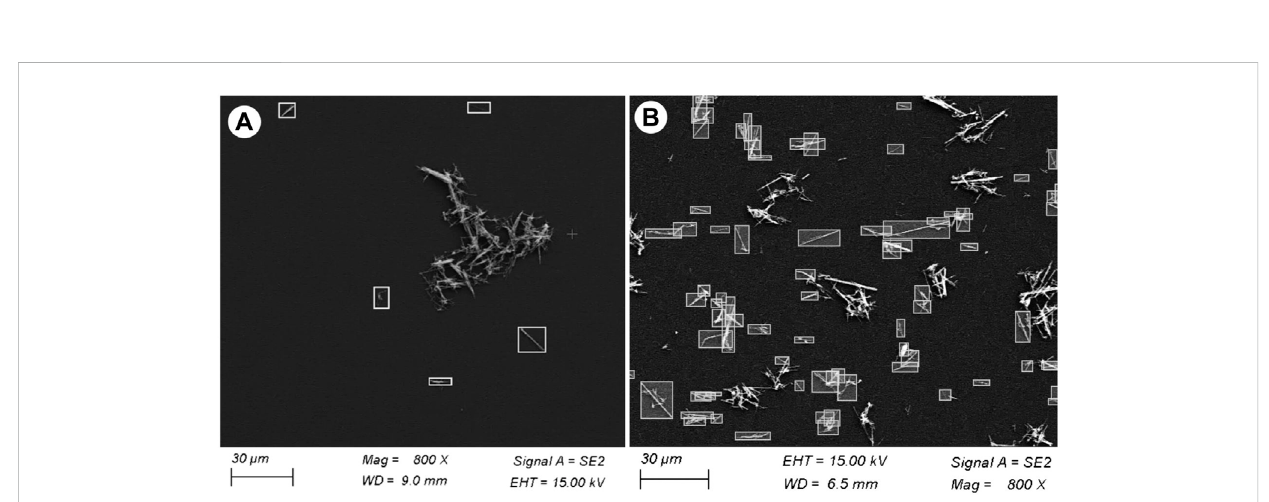
FIGURE 9 SelectedSEMimagesshowingasbestiform fi bresmanuallyannotatedasboundingboxesforcounting.Thechoiceofthe fi brestoannotatehasbeen based on NIOSH (Ashley and O ’ Connor, 2017) counting rules, see text for explanation. (A) Drop and (B) micro-drop depositions. Note that although the magni fi cation of both images is the same (×800), in the micro-drop deposition the distribution of the particles is extremely more